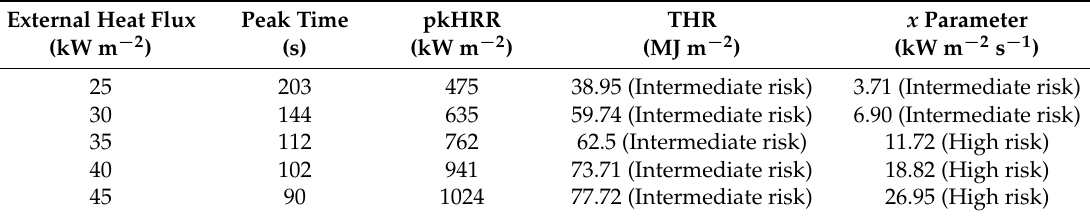
Table 2. Test results and thermal hazard